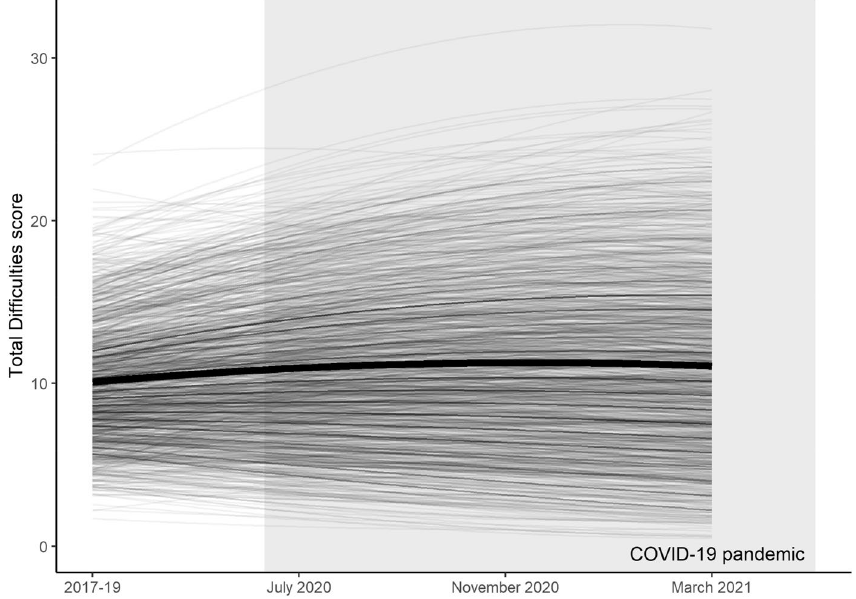
Figure 2. Latent growth curve model (bold) of adolescent SDQ Total Difficulties scores between 2017 and March 2021, based on the Understanding Society dataset. Individual predicted trajectories are also shown, along with the timing of the COVID-19 pandemic in